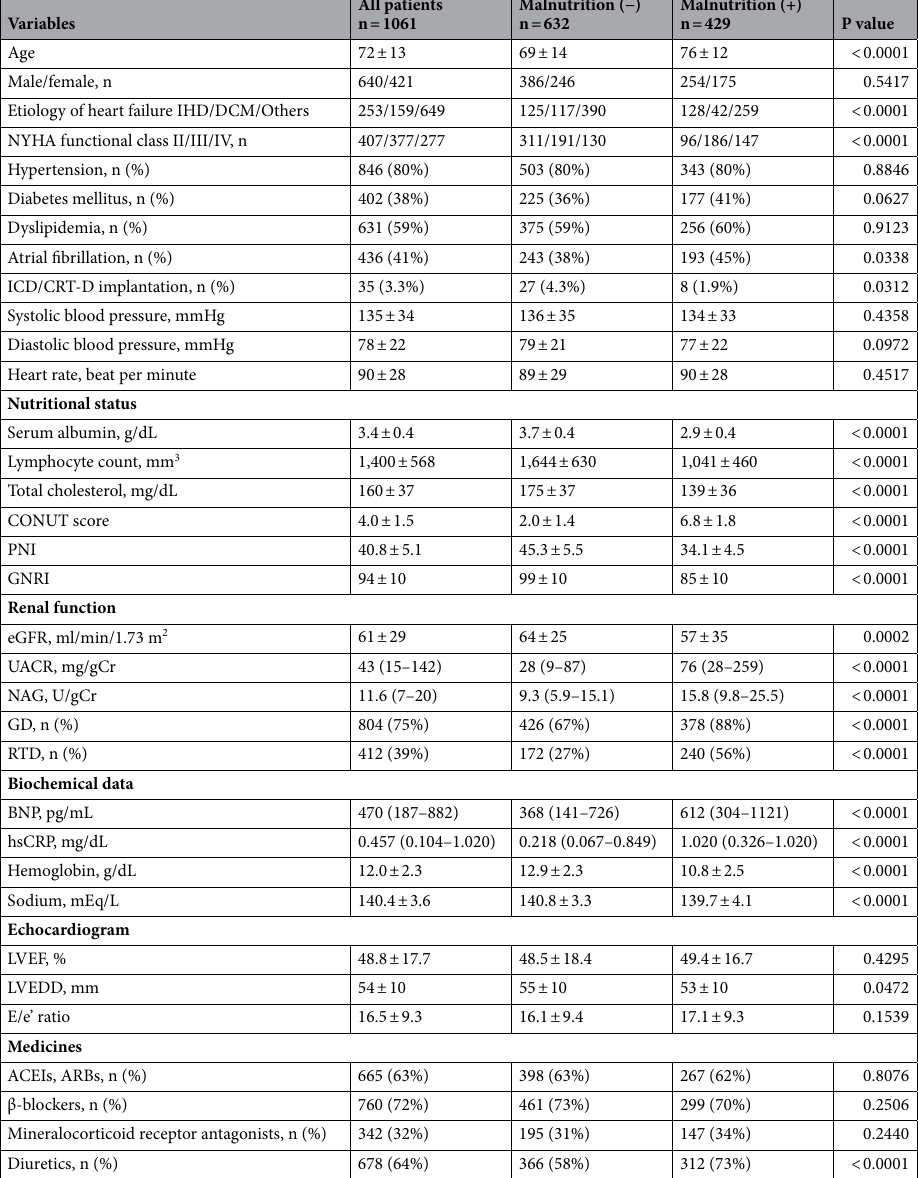
Table 1. Comparisons of baseline clinical characteristics between patients with and without malnutrition defined by high CONUT score. Data are expressed as mean ± SD, number (percentage), or median (interquartile range). ACEIs angiotensin-converting enzyme inhibitors, ARBs angiotensin II receptor blockers, BNP brain natriuretic peptide, CONUT controlling nutritional status, CRT-D cardiac resynchronization therapy defibrillator, DCM dilated cardiomyopathy, E/e ′ ratio the ratio of the mitral inflow E wave to the tissue Doppler e’ wave, eGFR estimated glomerular filtration rate, GD glomerular damage, GNRI geriatric nutritional risk index, ICD implantable cardioverter defibrillator, IHD ischemic heart disease, LVEDD left ventricular end diastolic dimension, LVEF left ventricular ejection fraction, hsCRP high sensitivity C-reactive protein, NAG N -acetyl-beta-d-glucosamidase, NYHA New York Heart Association, PNI prognostic nutritional status, RTD renal tubular damage, UACR urinary microalbumin-creatinine